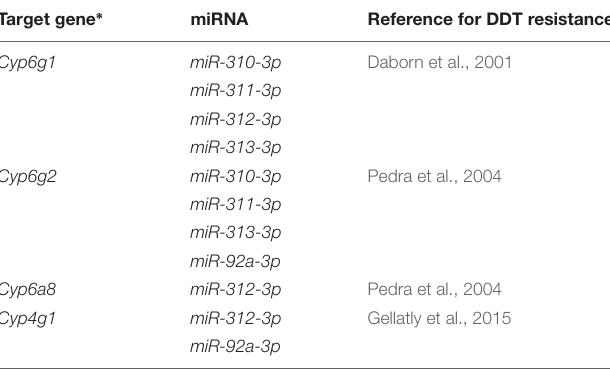
TABLE 1 | The potential DDT resistance-related target P450s of the differentially expressed miRNAs. Target gene